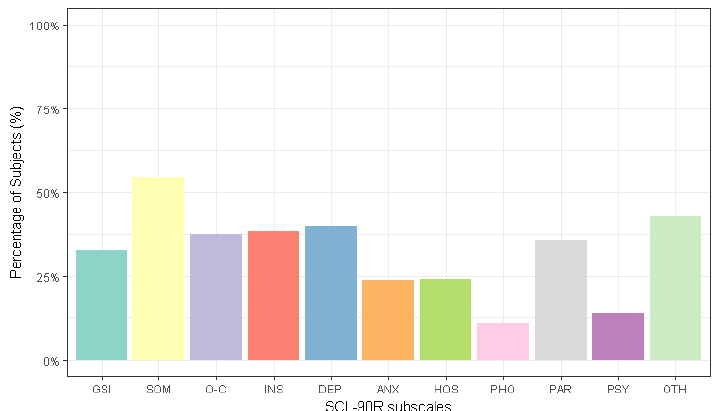
Figure 2. The percentage of subjects with scores that were above the general population cut ‐ offs for the SCL ‐ 90 ‐ R (total sample): GSI, Global Severity Index; SOM, somatization; O ‐ C, obsessive–compulsive; INS, interpersonal sensibility; DEP, depression; ANX, anxiety; HOS, hostility; PHO, phobic anxiety; PAR, paranoidal ideation; PSY, psychoticism; OTH, other symptoms (additional items). The percentage of people who reported scores that were above the cut ‐ offs for the different SCL ‐ 90 ‐ R domains varied across the binge eating disorder severity classes, as shown in Figure 3.